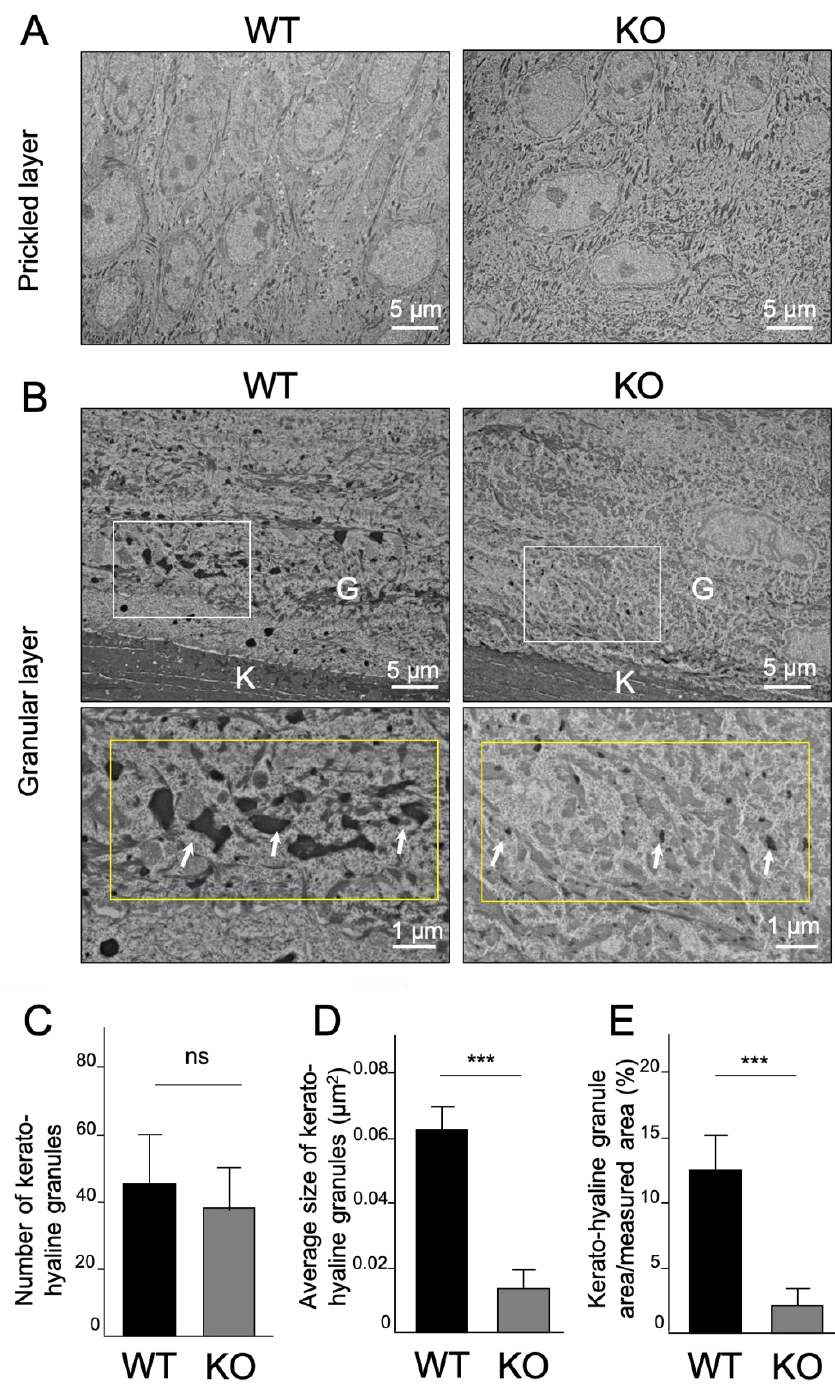
Figure 5. Ultrastructural comparison of keratinized mucosa between WT and Col18 -KO mice. ( A,B ) Transmission electron microscope (TEM) images of (A) prickled layer and (B) granular layer in palatal mucosa of WT and Col18 -KO mice. Arrows indicate keratohyalin granules (KHG) in the granular layer. White boxes indicate the area shown at higher magnification in the lower panels and yellow boxes indicate the total measured area for calculation of the ratio between the KHG area and total measured area. The number, average size, and percentage area of KHG are shown in graph ( C ), ( D ), and ( E ), respectively. Bars represent the mean values and standard deviation (+/−SD) ( n = 4). *** p < 0.001, ns: no significant difference (Student’s t -tests). Note that a clear difference in the size and area of KHG could be observed in the granular layer, but not in the prickled layer.